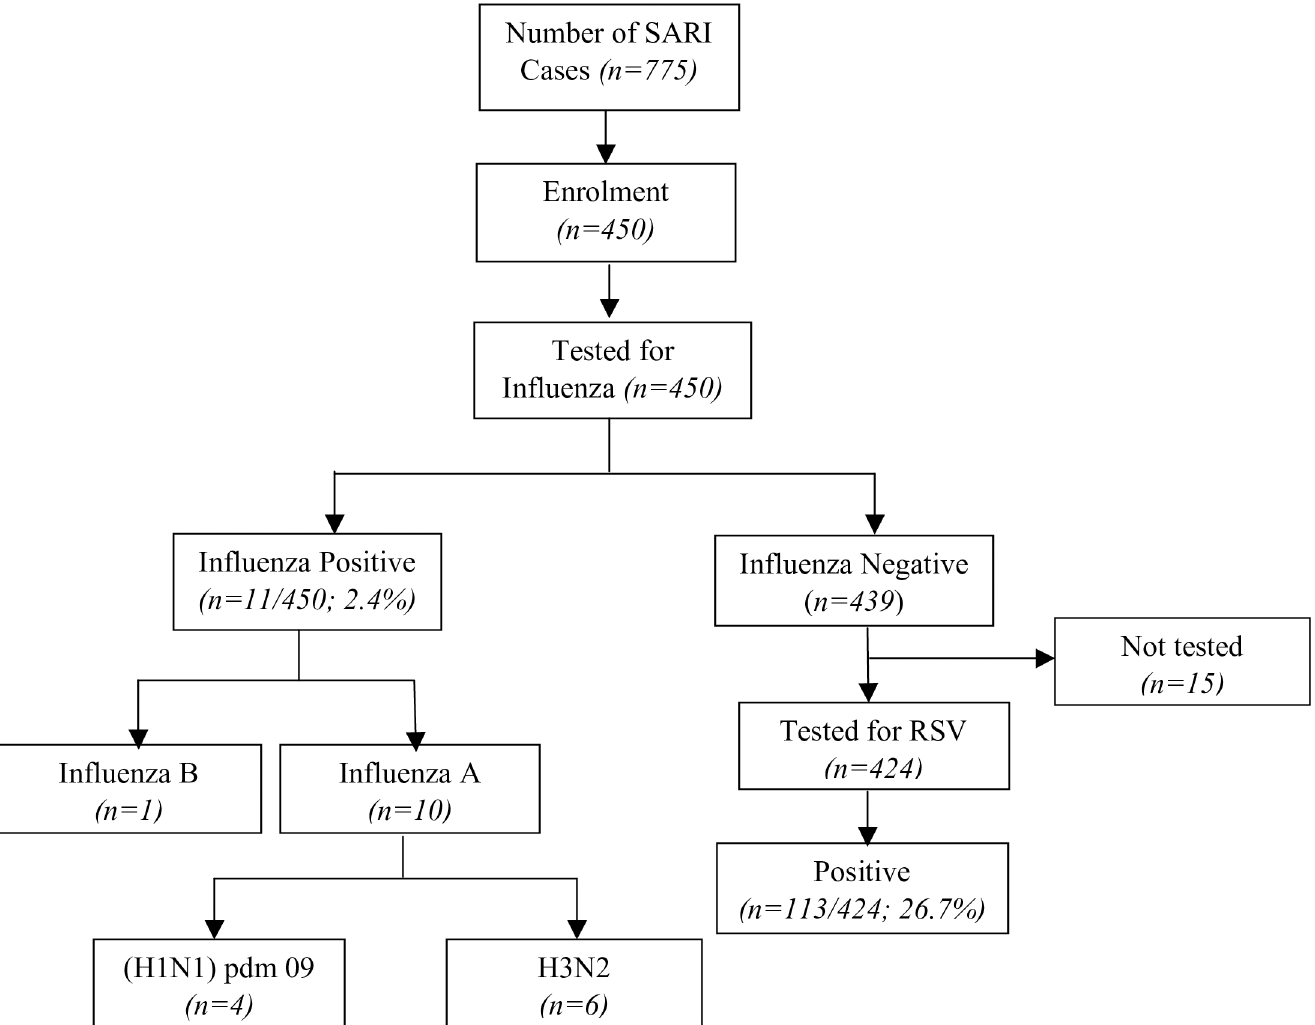
Fig 1. Flowchart of recruitment of study participants and sample testing. Of the 439 negative samples for influenza, 424 were tested for RSV; 15 sampleswere not tested due to lack of reagents.